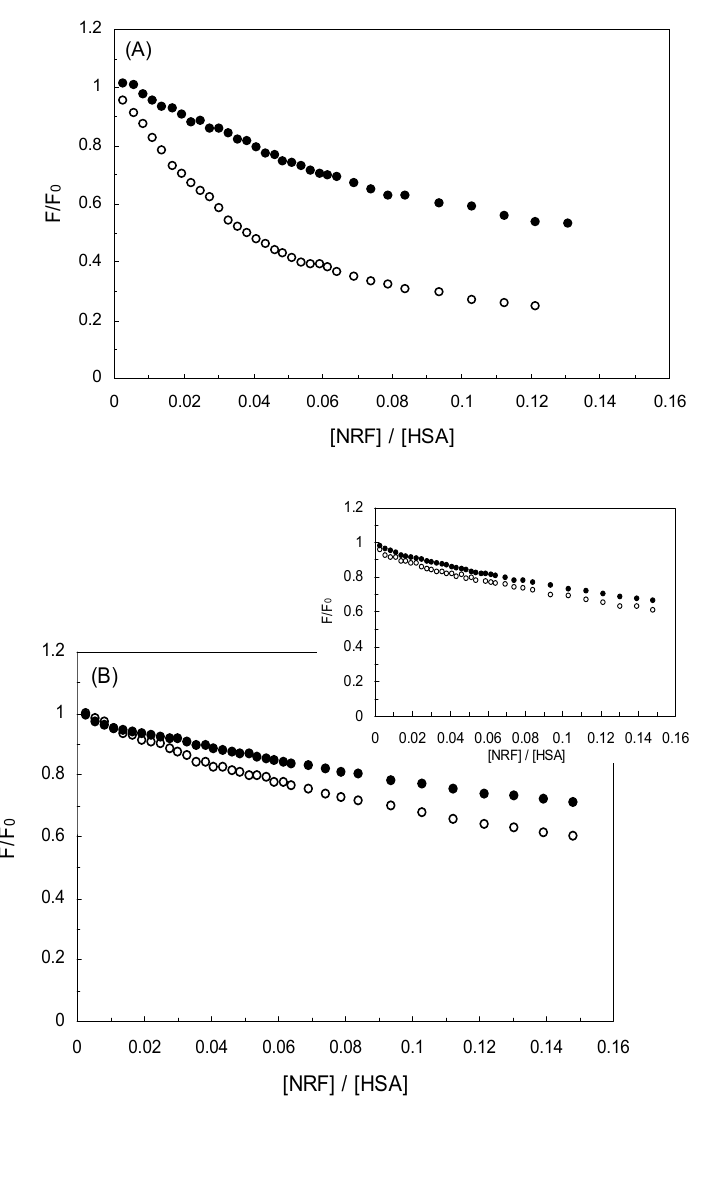
Figure 3. Comparison of the quenching curves for HSA-NRF in the absence and presence of EMFs. T = 298 K; pH 7.40. λ = 280 nm ( ○ ); λ = 295 nm ( ● ). ( A ) HSA-NRF; ex ex ( B ) 100 Hz/2.4 mT, (inset) 100 Hz/6.4 mT; ( C ) 1 KHz/1.9 mT, (inset) 1 KHz/0.98 mT; ( D ) 10 KHz/63 μ T, (inset) 10 KHz/0.17 mT; ( E ) 100 KHz/39 μ T, (inset) 1 MHz/59 μ